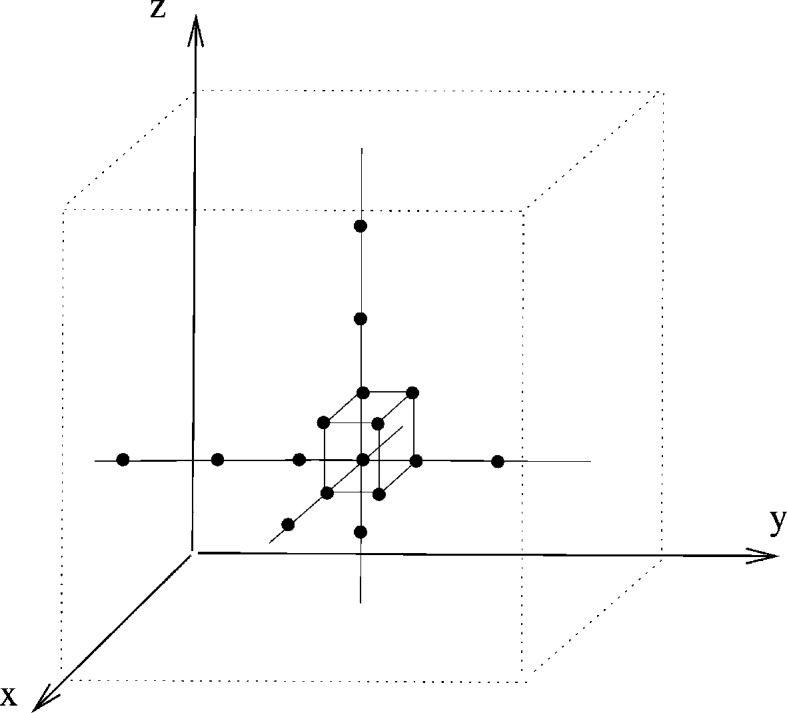
A chain subgraph knot of k · K
pcu.